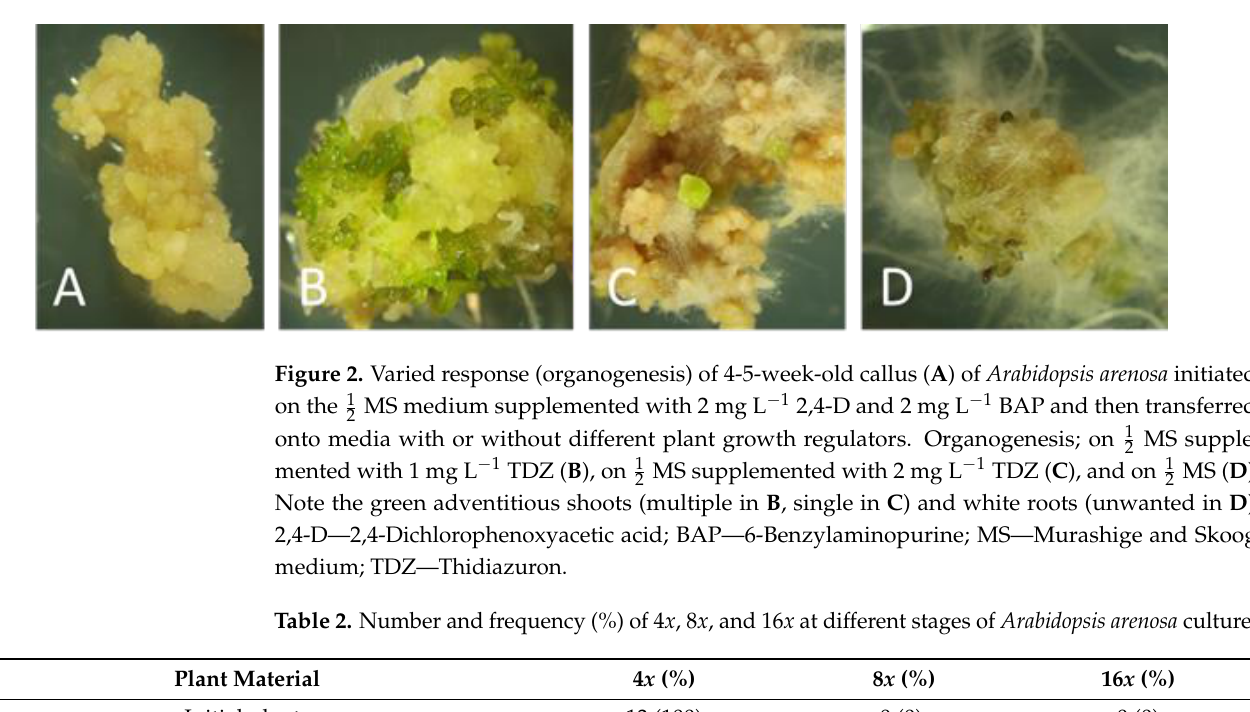
Figure 1. Successive stages of obtaining Arabidopsis arenosa regenerants. Fragments of seedlings laid